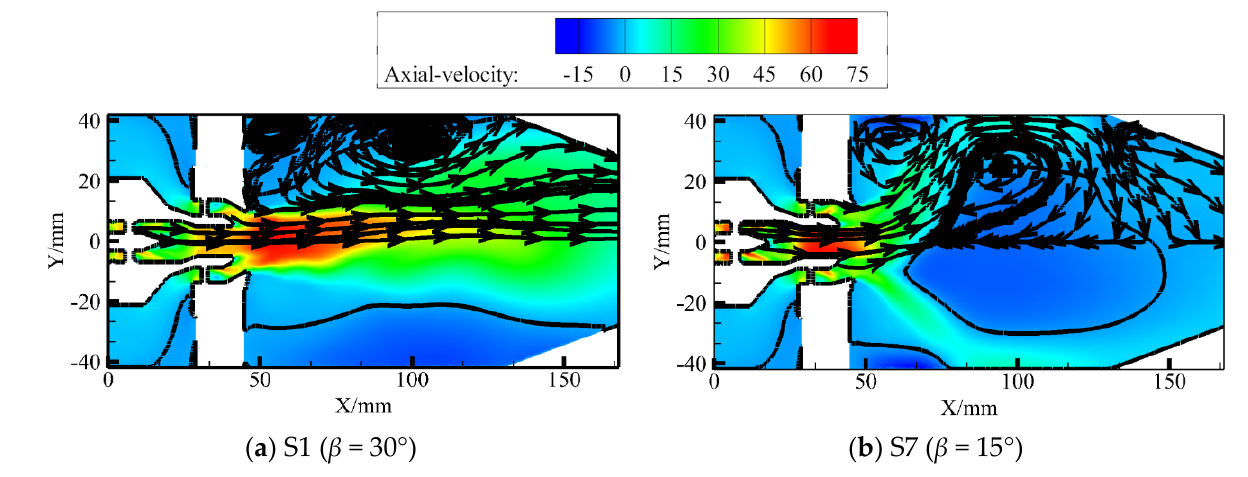
Figure 17. Axial velocities contours and streamline under different sleeve angles.